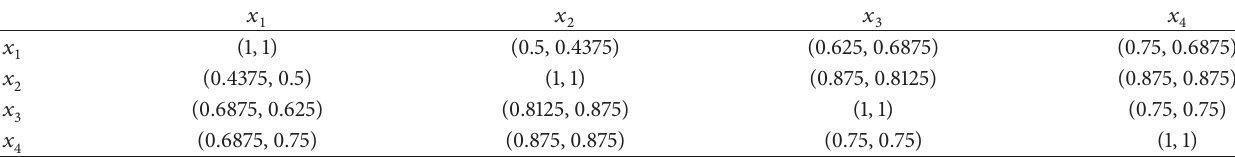
Table 5: Consensus levels of preference values provided by 𝑒 2 .